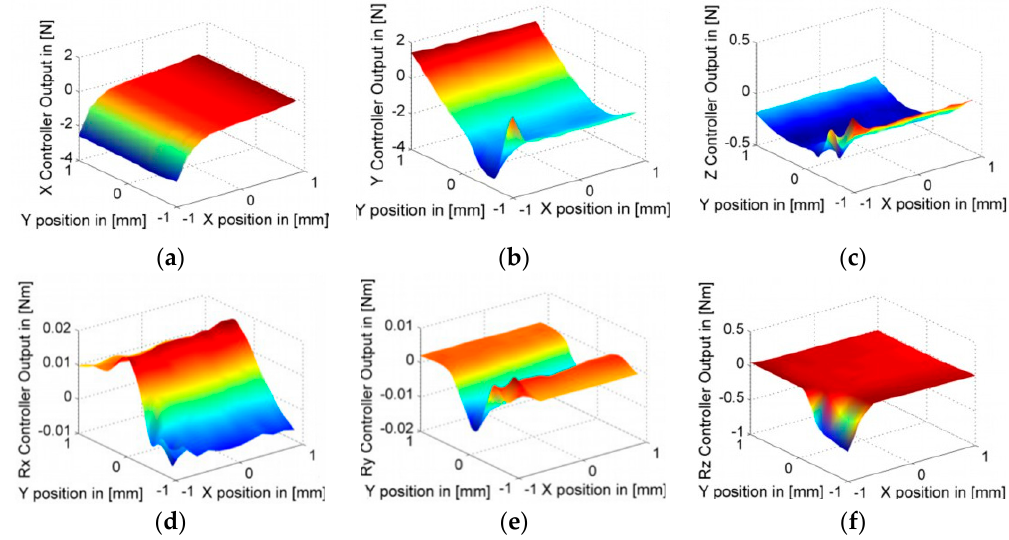
Figure 8. Distribution of PDDFs in ( a ) X, ( b ) Y, ( c ) Z, ( d ) Rx, ( e ) Ry, and ( f ) Rz degrees-of-freedom (DoF) in the horizontal plane for Z = − 0.4 mm.